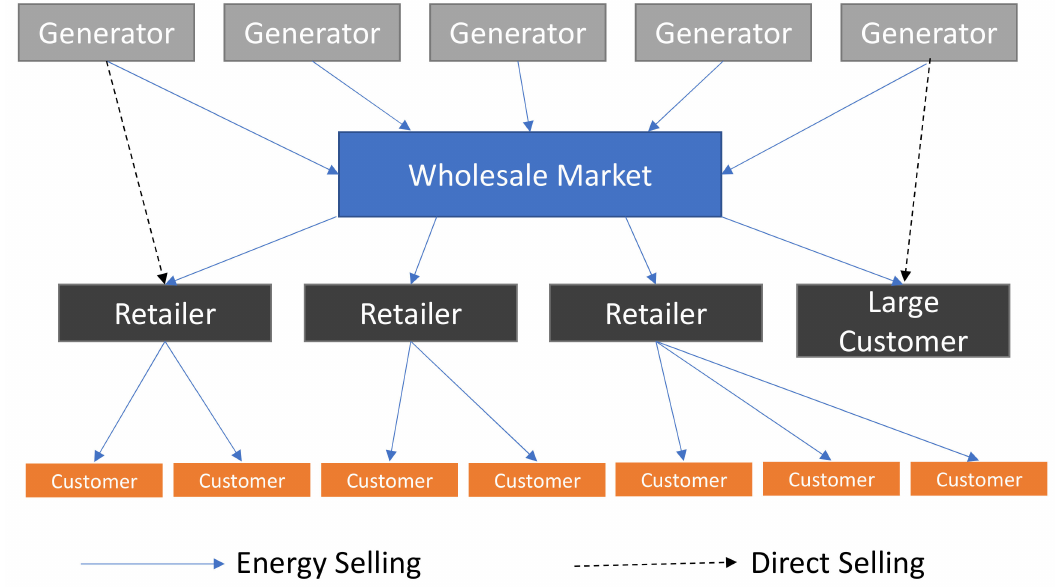
Figure 10. Competitive retail energy market (adapted from